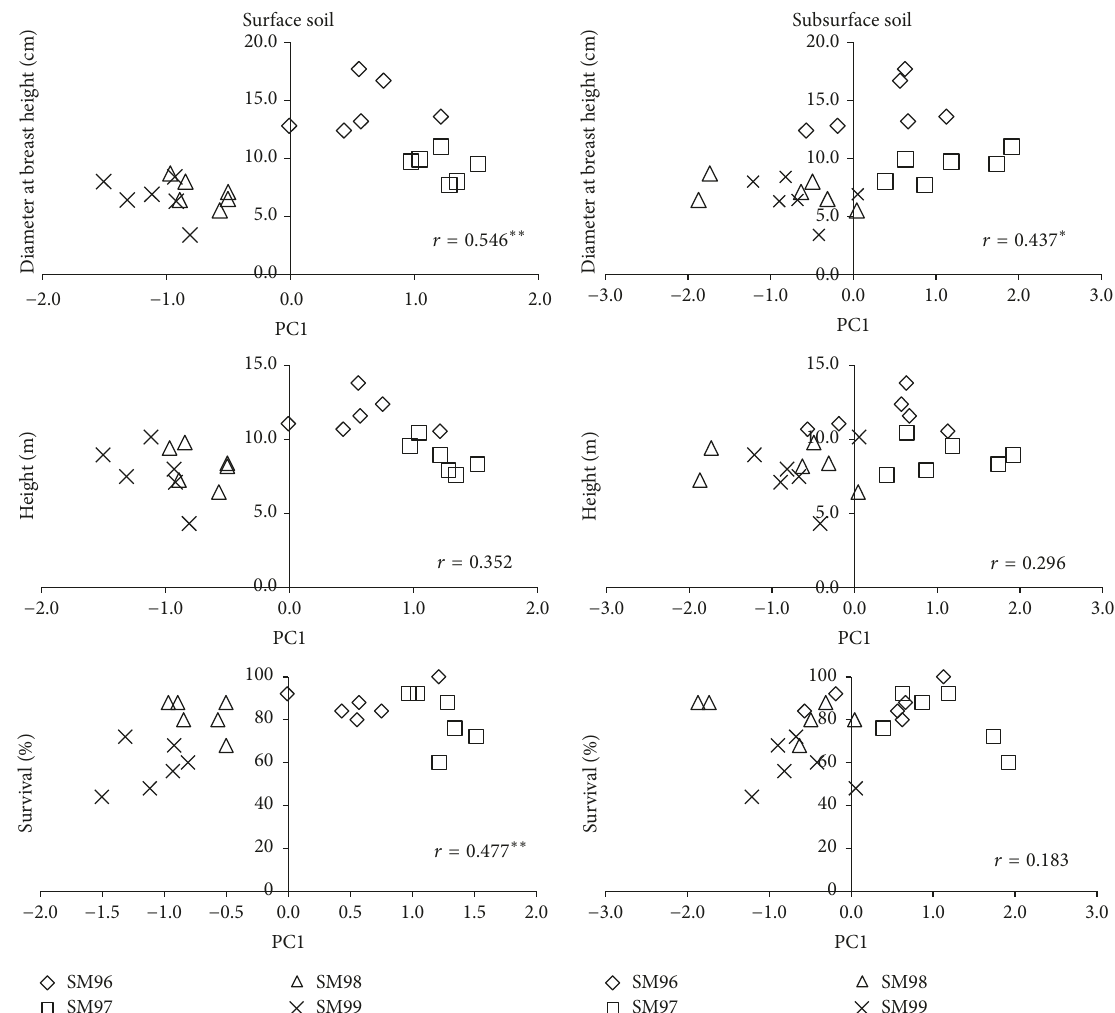
Figure 3: Relationship between PC1 score, diameter at breast height (DBH), height, and percentage of survival derived from surface and subsurface soils. ∗,∗∗ Correlations are significant at 5% and 1% levels, respectively, using Pearson correlation matrix.